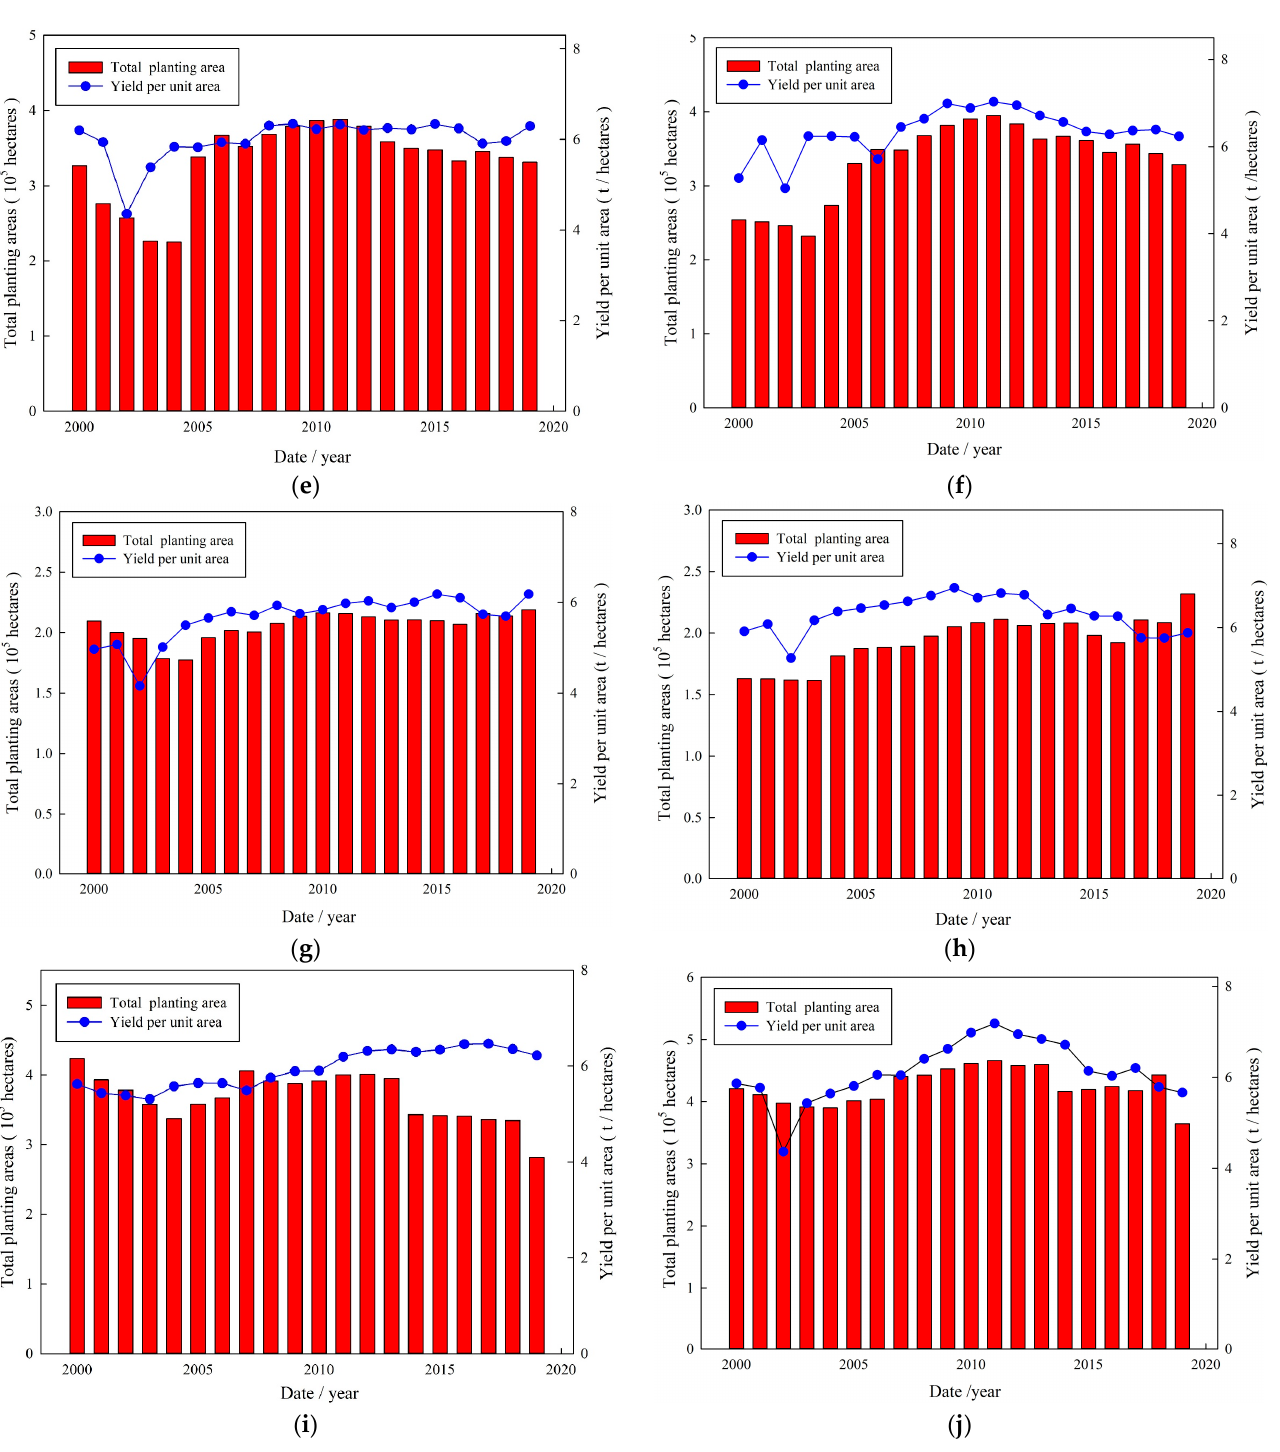
Figure 2. Planting areas and yield per unit hectare of winter wheat and summer maize in five cities. ( a ) Winter wheat in Anyang; ( b ) summer corn in Anyang; ( c ) winter wheat in Zhengzhou; ( d ) summer corn in Zhengzhou; ( e ) winter wheat in Weifang; ( f ) summer corn in Weifang; ( g ) winter wheat in Jinan; (h) summer corn in Jinan; ( i ) winter wheat in Baoding; and (j) summer corn in Baoding.